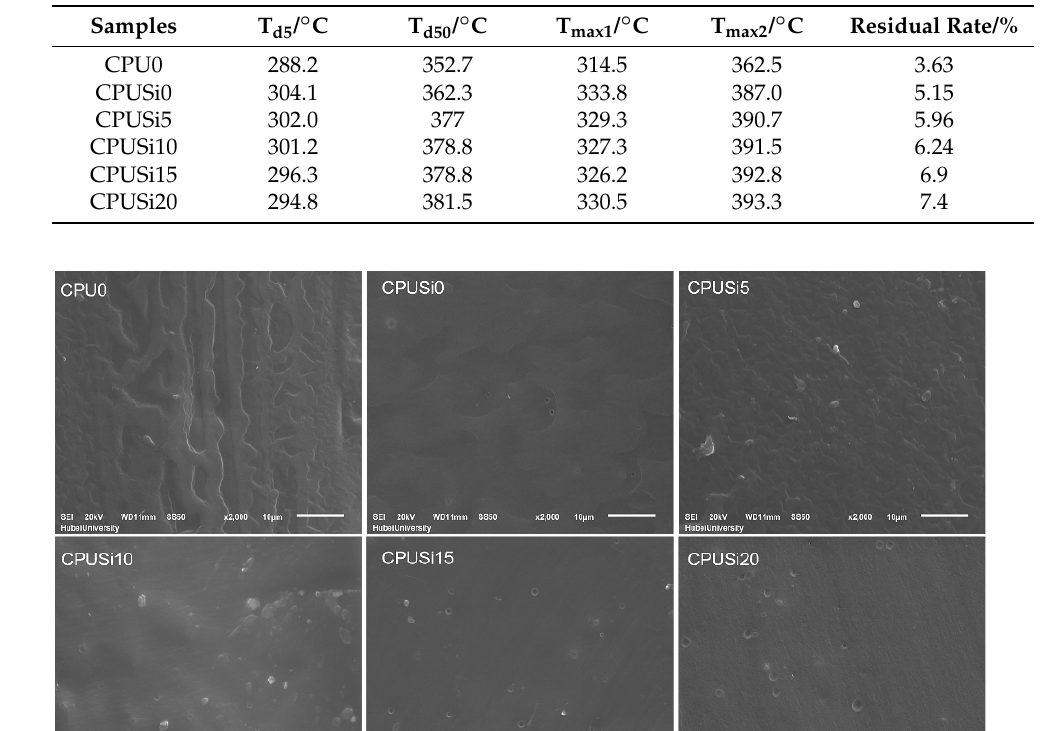
Table 3. Thermal parameters of the CPU and CPUSi films.